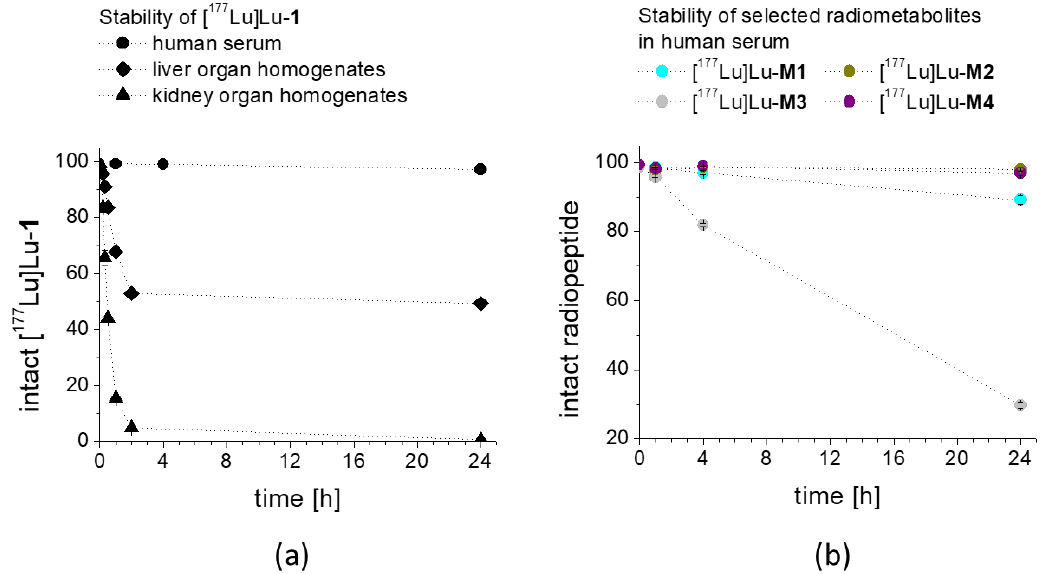
Figure 3. Stability of ( a ) [ 177 Lu]Lu- 1 after incubation in human serum as well as in rat liver and rat kidney homogenates, and of ( b ) selected radiolabeled metabolites M1 – M4 in human serum, as analyzed up to 24 h after incubation.